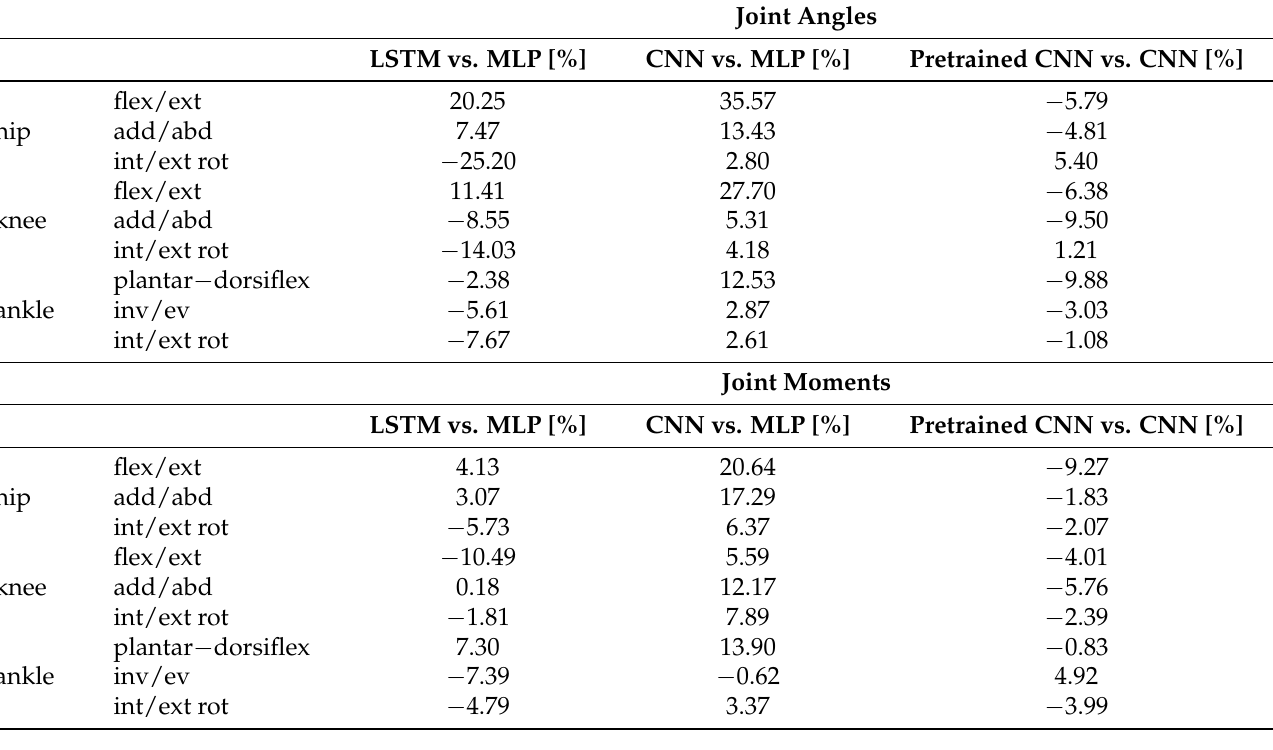
Table 2. Comparison of the different neural networks. Values display the difference in nRMSE values. Positive values show an improvement compared to the baseline (MLP or CNN from scratch).